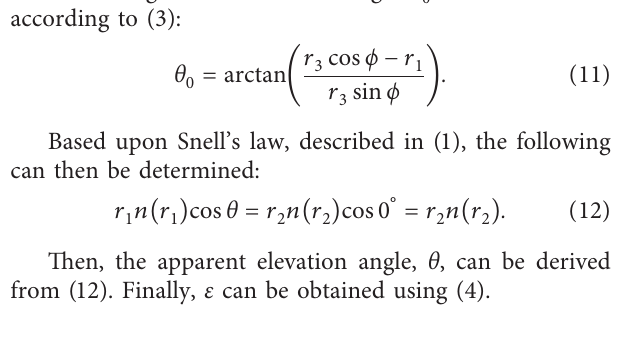
Figure 1: A schematic representation of atmospheric refraction. τ : bending angle, ρ : angle between the tangent of point 2 and line segment 12, θ : apparent elevation angle, θ : geometric elevation 0 angle, r and r : distances from Earth’s centre to points 1 and 2, 1 2 respectively, ϕ : spherical angle between points 1 and 2, r e : radius of Earth, and h : ray height above sea